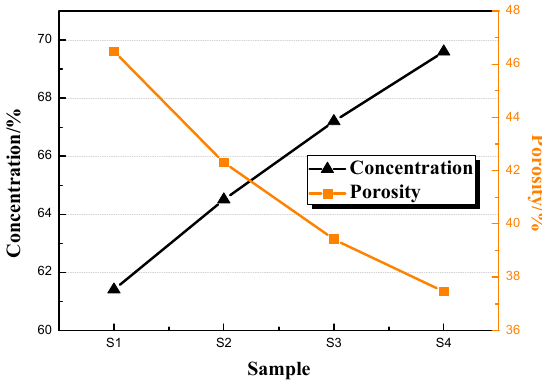
Figure 7. Porosity concentration distribution curve.